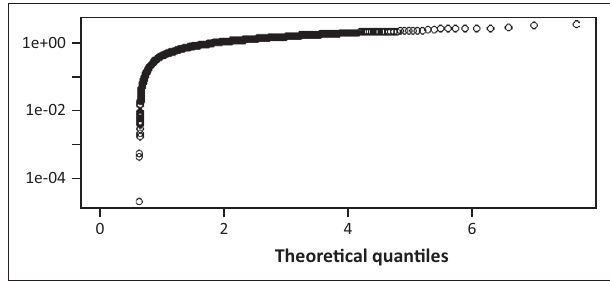
FIGURE 3: Pareto quantile plot of asymmetric power auto-regressive conditional heteroscedastic (1,1) model (normal innovations) residuals.